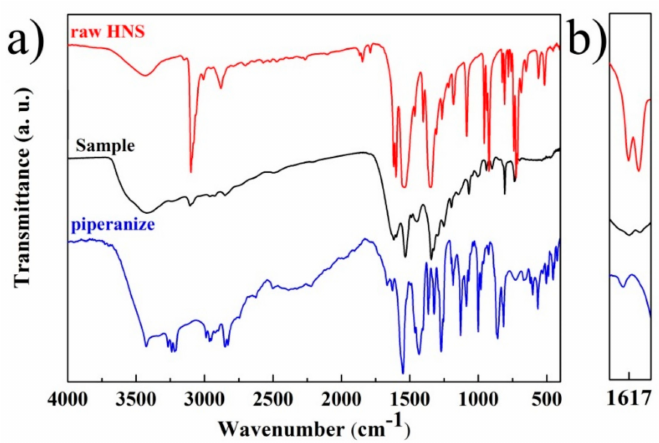
Figure 7. ( a ) The FT-IR patterns of raw HNS (red), piperazine (blue) and the sample: nanoenergetic derivatives (black), ( b ) Magnified FT-IR patterns from ( a ).